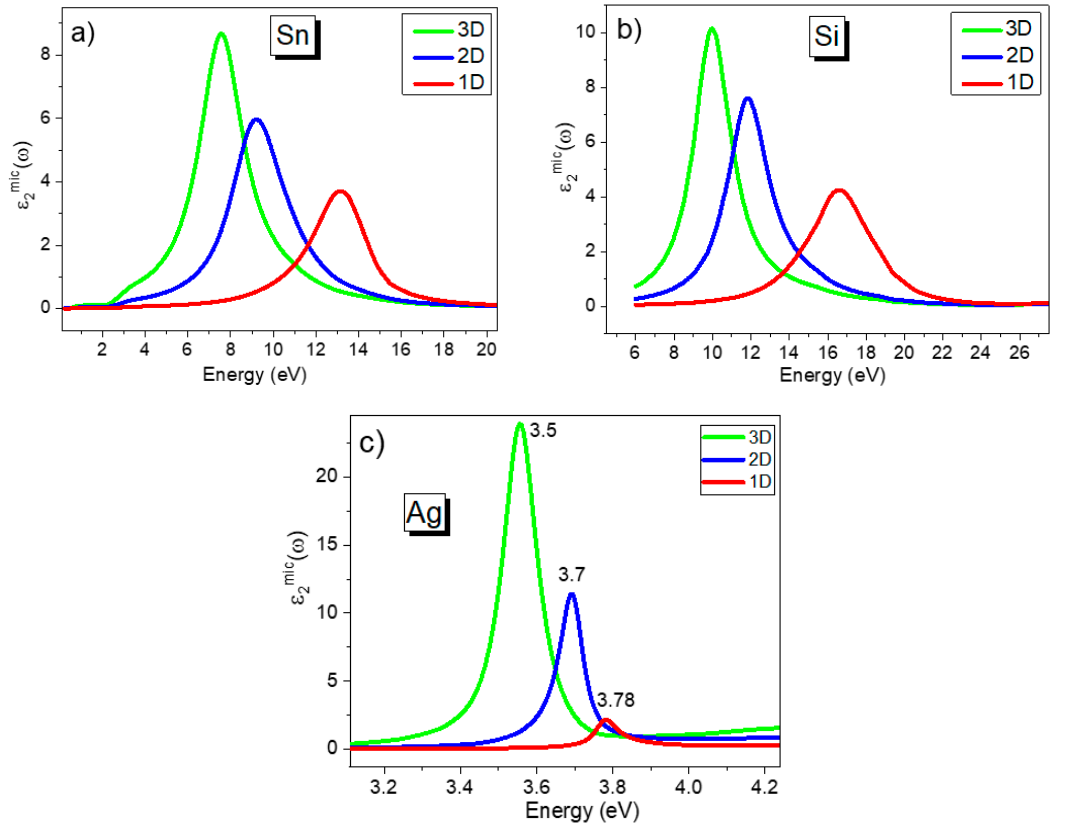
( ω ) for 1D, 2D and 3D confinements for ( a ) Sn, ( b ) Si and ( c ) Figure 2. Calculated spectra ε mic Figure 2. Calculated spectra 𝜀 (cid:2870)(cid:3040)(cid:3036)(cid:3030) (𝜔) for 1D, 2D and 3D confinements for ( a ) Sn, ( b ) Si and ( c ) Ag. 2